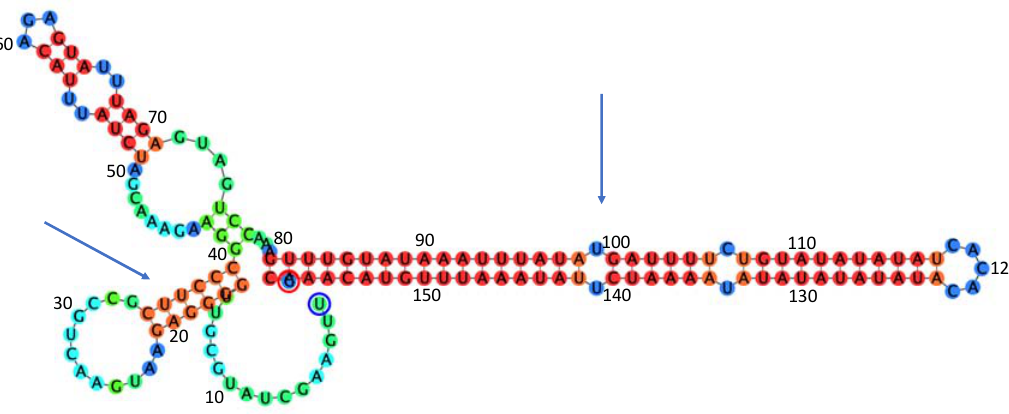
Figure 5. Secondary structure prediction for the 3 (cid:48) UTR computed by RNAfold implemented in Geneious Prime 2020. The blue arrow indicates the stem-loops that are predicted to remain stable up to 64 ◦ C with a free energy of the thermodynamic ensemble ∆ G = − 18.38 kcal / mol in 1 M NaCl. The color of the nucleotides is related to the base pair probabilities provided by RNAFold: red, very high; orange, high; green, medium; blue, low.